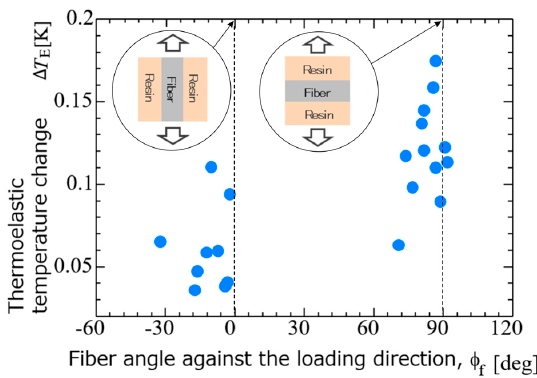
Figure 5. Relationship between thermoelastic temperature change ∆ T E and fiber orientation angle φ f .